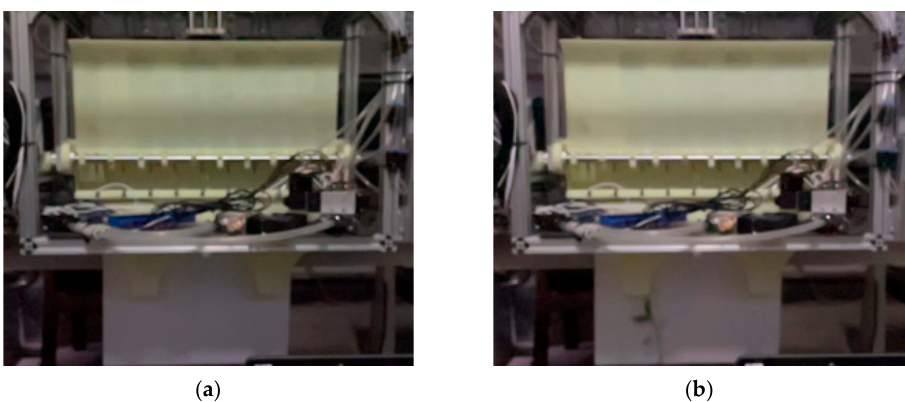
Figure 11. Key frames of seedling dropping process. ( a ) The pot seedlings begin to fall. ( b ) The pot seedlings completely fall